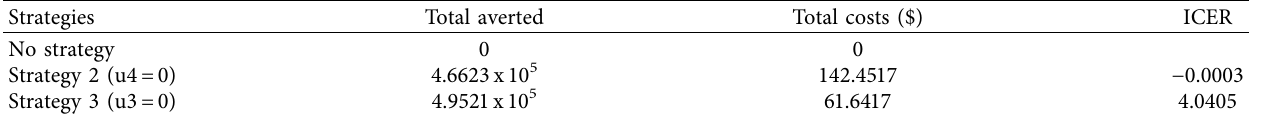
Table 5: Rank of strategies based on the number of the infection averted.